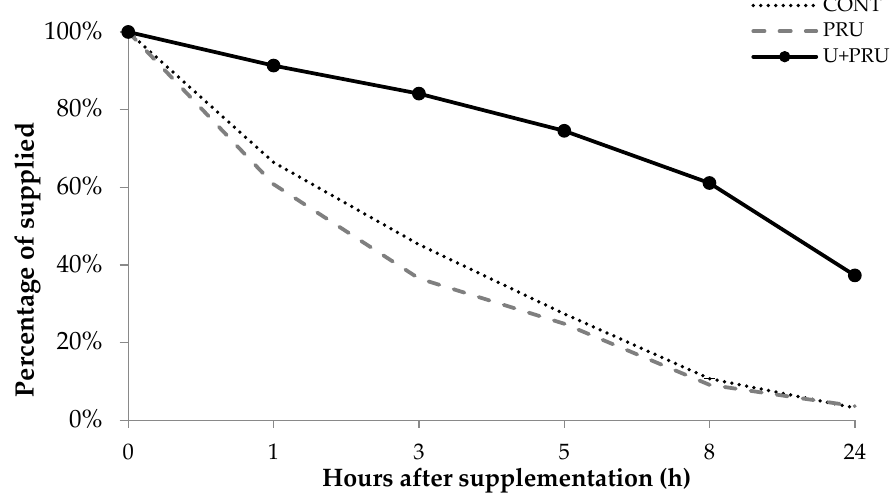
Figure 3. Disappearance rate of supplements as a function of the use of post-ruminal urea and conventional urea in Nellore young cattle in the dry season. ( p -value: Treatment: <0.001; Hour: <0.001; and Treatment vs. Hour: <0.001).